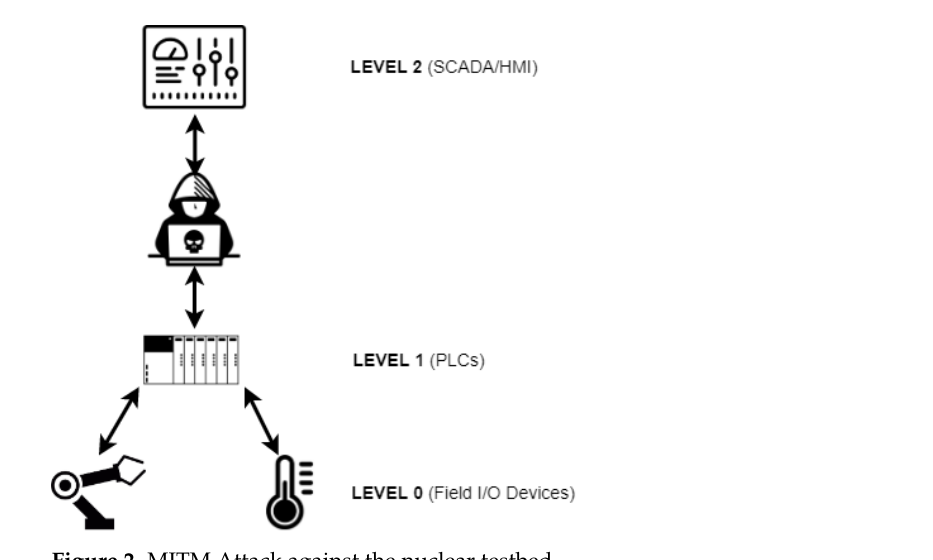
Figure 2. MITM Attack against the nuclear testbed.